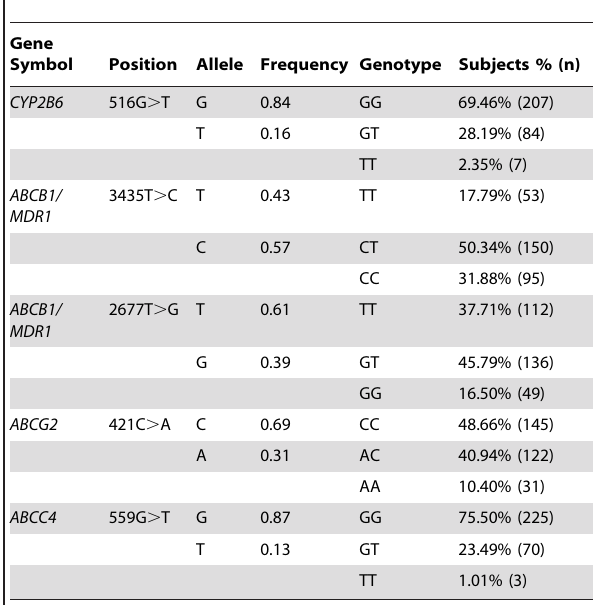
Table 1. Demographic characteristics of the Henan cohort (N= 298).